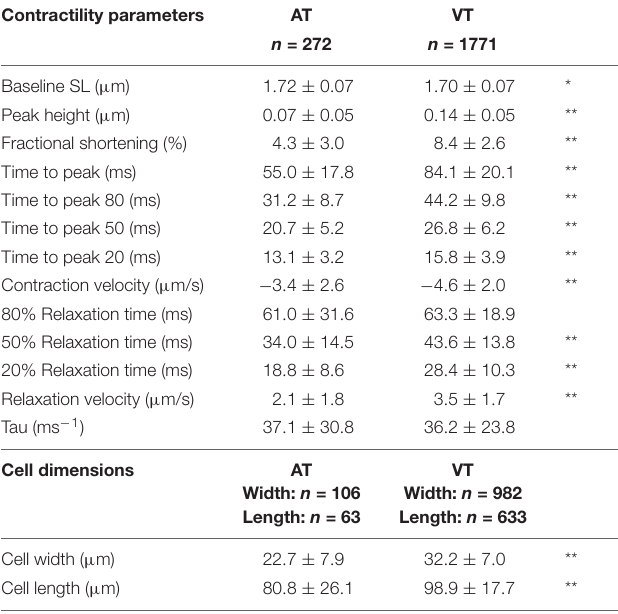
TABLE 1 | Contractile and cell dimension differences between AT and ventricular (VT) cells.